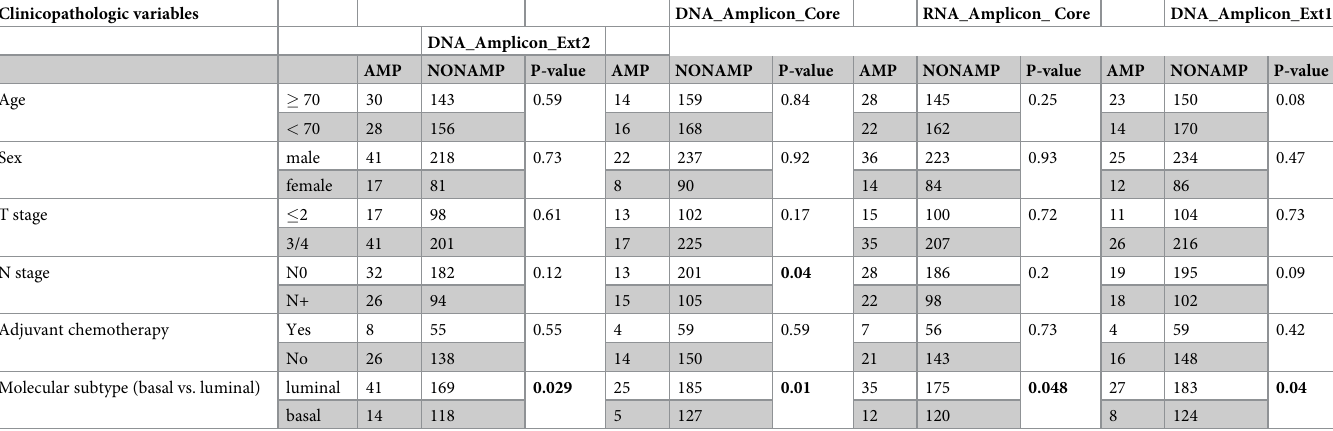
Comparison of clinical parameters between AMP and NONAMP patients for DNA Amplicon Core, DNA Amplicon Ext1, DNA Amplicon Ext2, and RNA Amplicon Core. Significant p-values are highlighted in